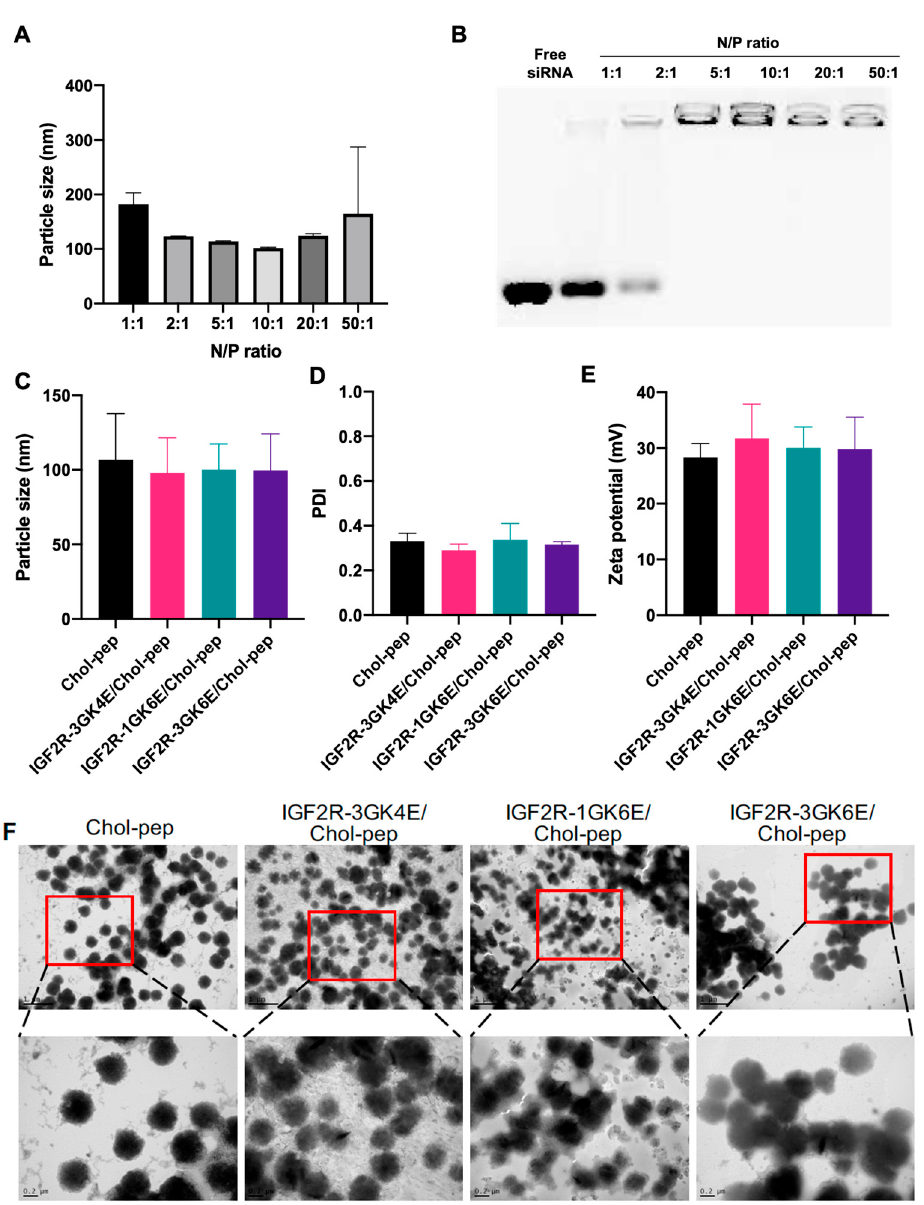
Figure 2. Characterization of the nanocomplex. ( A ) Particle size and ( B ) gel retardation assay of the cholesteryl peptide nanocomplexes at different N/P ratios. ( C ) Particle size, ( D ) PDI, ( E ) Zeta potential, ( F ) TEM images of the dimeric IGF2R peptide-modified nanocomplexes.